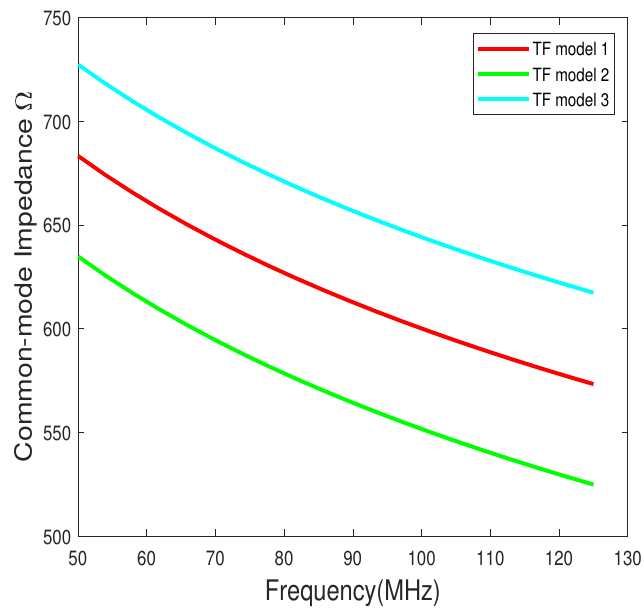
Figure 16. Common mode characteristic impedance of two-fold (TF) antenna models with respect to frequency. TF models 4 will show similar characteristic impedance as TF model 1. Here we have modeled the two fold antenna as two single-fold antennas in series.